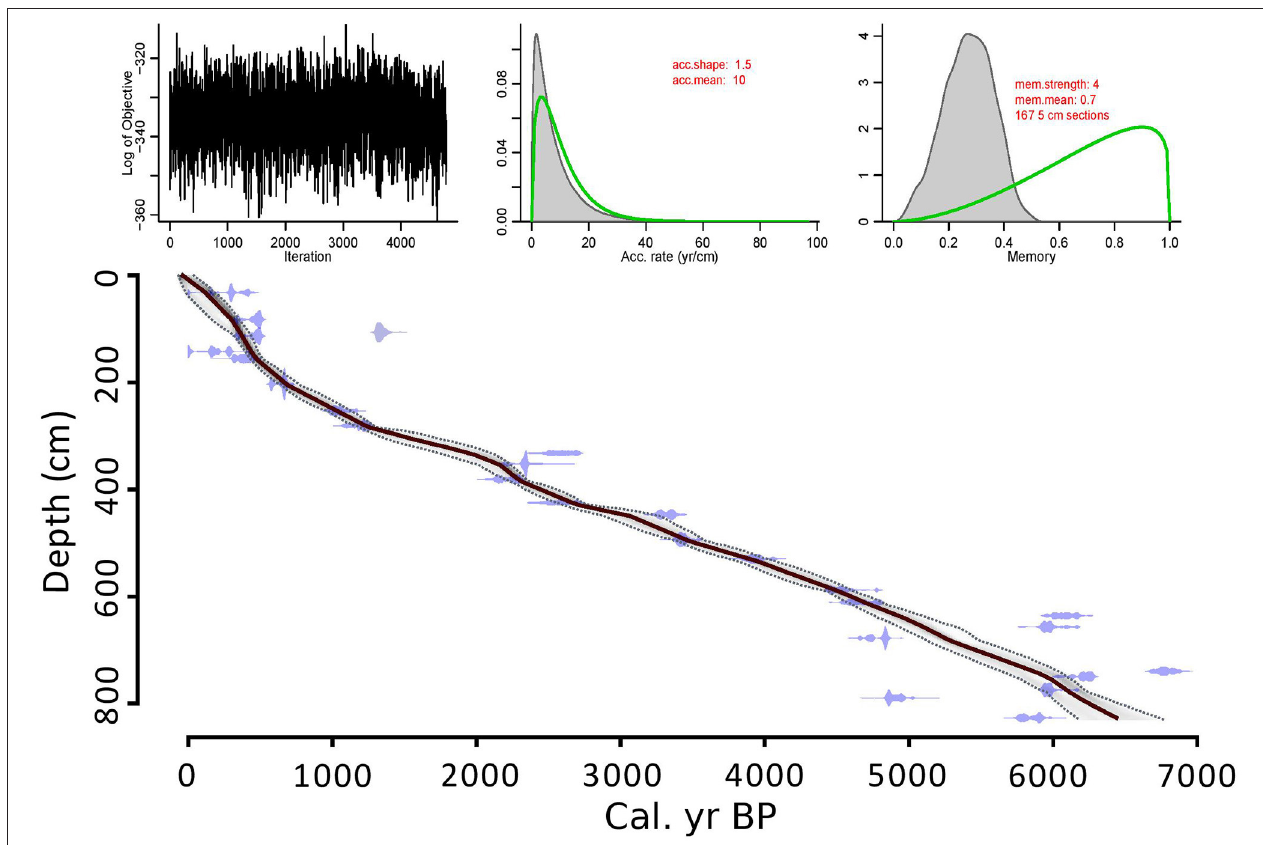
FIGURE 9 | Age–depth model output from the software Bacon (Blaauw and Christen, 2011). The model is based on 26 radiocarbon dates (blue marks), and the associated age probabilities for each individual sample are shown. Some radiocarbon dates were rejected as they deviated notably from the overall best fit (see section